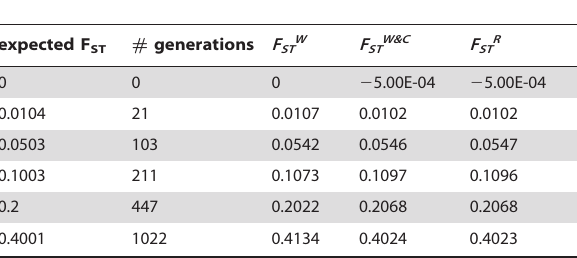
Table 1. Estimated F ST values on complete